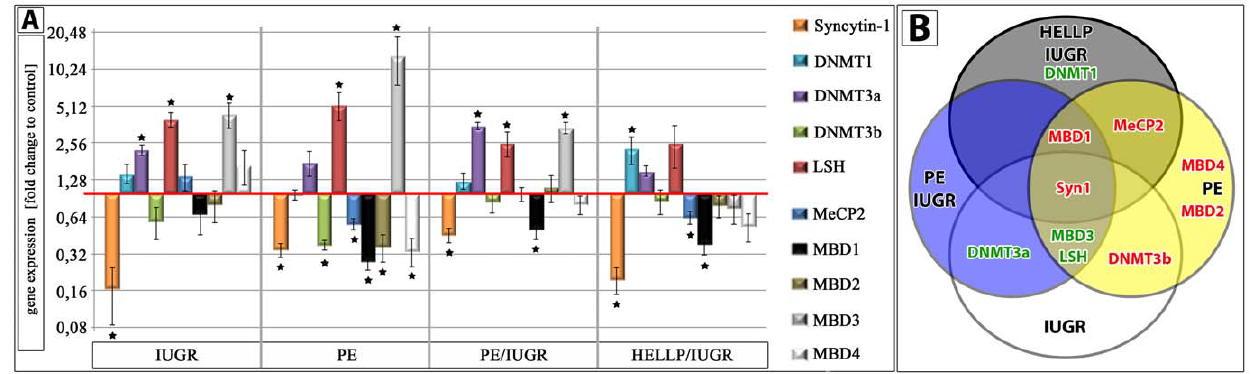
Figure 4. Gene expression profile of Syncytin-1 and methyl-binding proteins in isolated trophoblasts. A) Histograph showing fold- change differences to gene expression profile (2 2 DD CT ) of control trophoblasts of IUGR, PE, PE/IUGR and HELLP/IUGR (each n=7). Red line marks gene expression profile of control trophoblasts set to 1. (*P # 0.05). B) Venn diagram showing for each placental syndrome the statistical significant different expressed genes compared to control VCTs. The intersection of all four placental syndromes represents